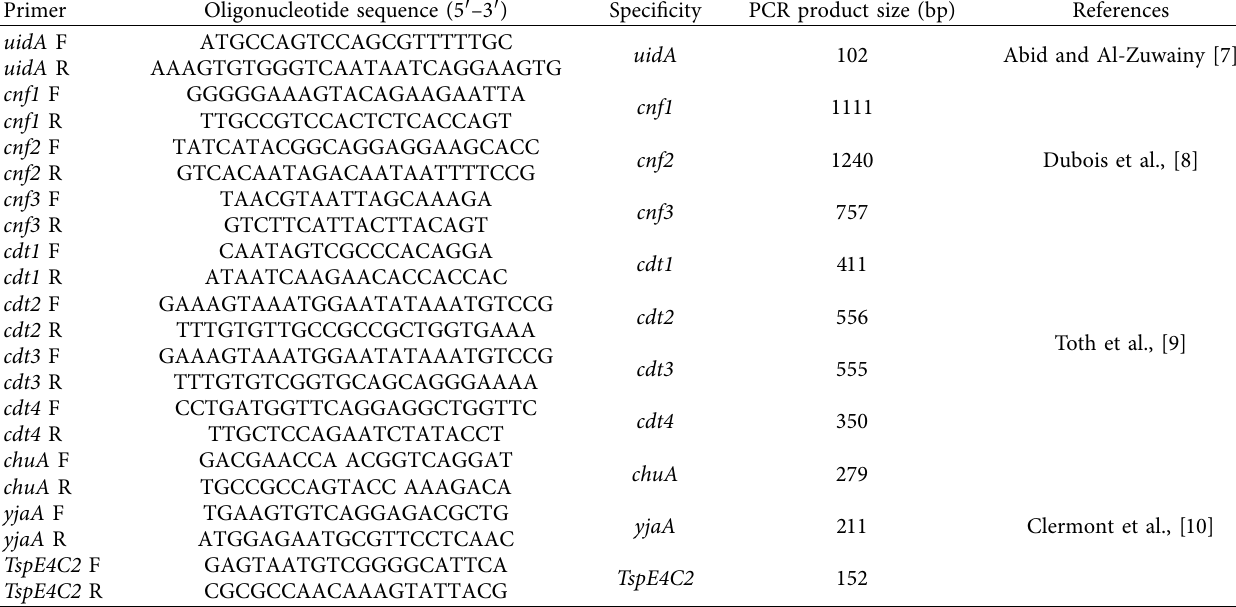
Table 1: Oligonucleotide primers are used in this study.